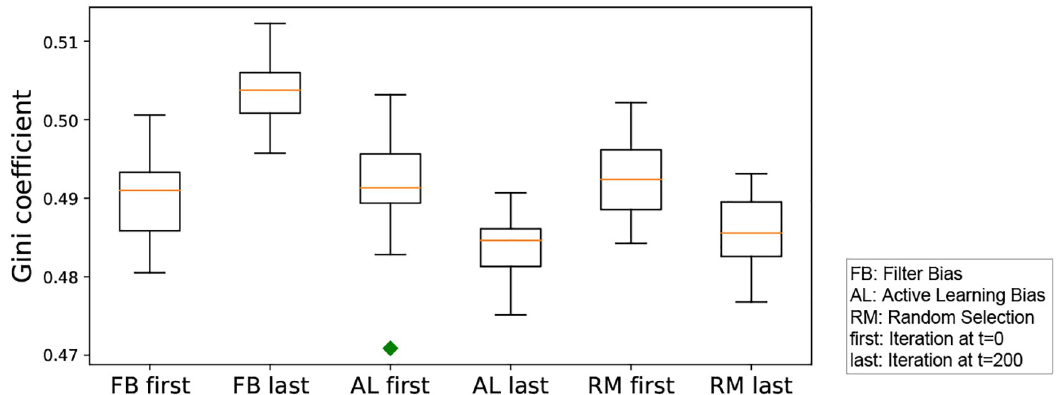
Fig 13. The box-plots showing the inequality score at the first and last iterations of the iterated learning for three iterated algorithmic biases with human action probability ratio 10:1. Filter bias significantly increases the Gini coefficient. On the other hand, random selection significantly decrease the Gini coefficient, as well as the active learning.